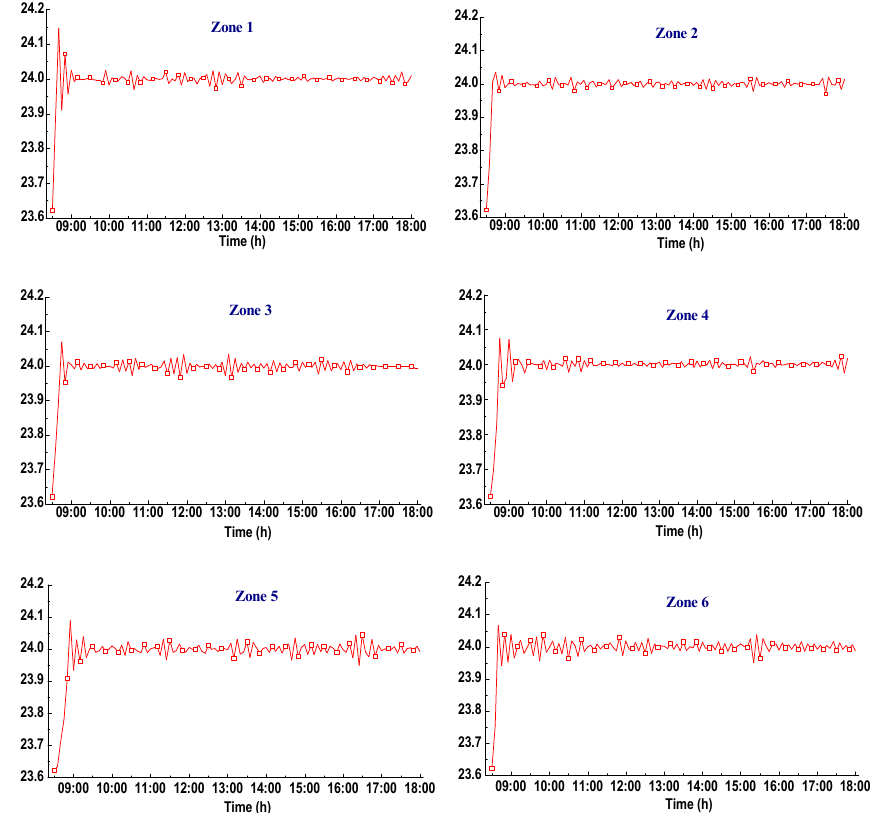
Figure 12. Changing patterns of the indoor air temperature of the six zones, under Scenario 3.